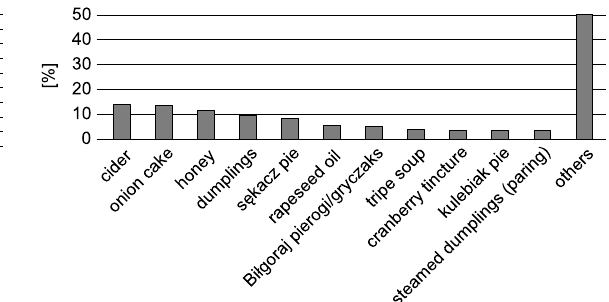
Fig. 3. Respondent’s general connotations with lubelskie voivodeship.